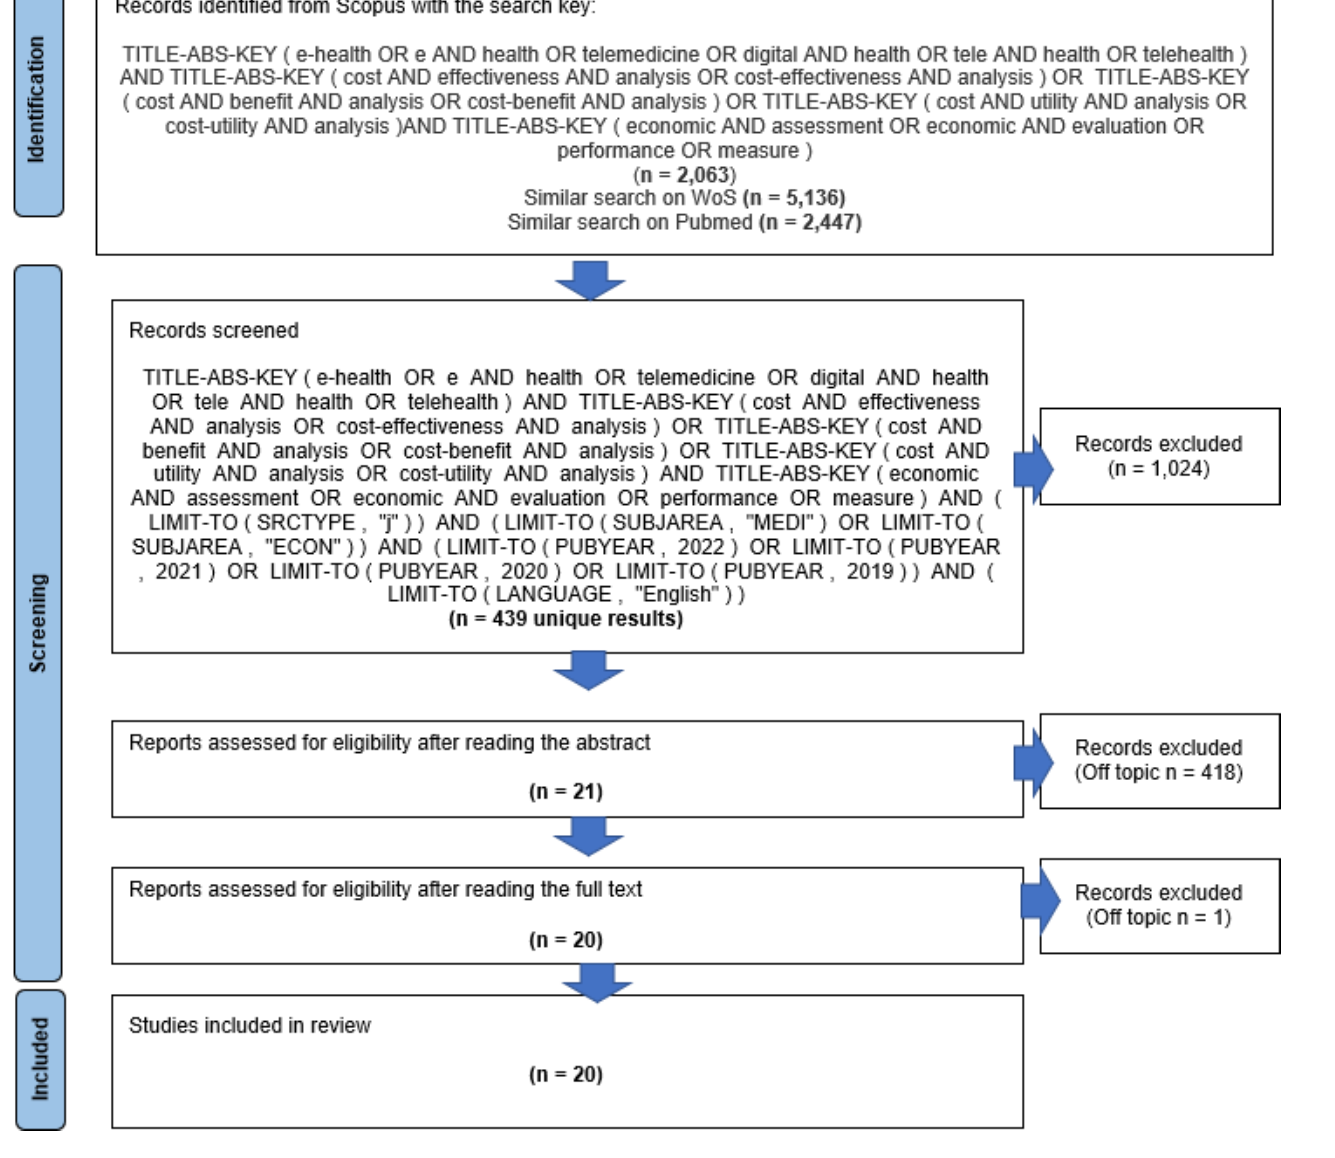
Figure 1. Flowchart of literature review steps, according to the PRISMA protocol. Adapted from Page et al. [42]. Search conducted on 3 December 2022.